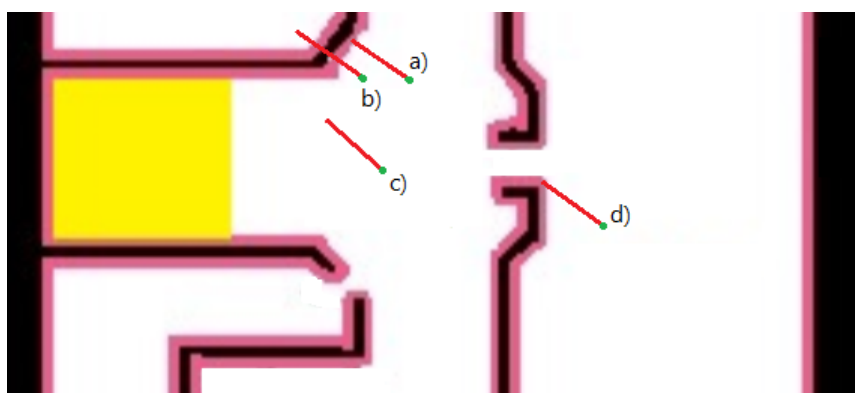
Figure 7. Consider the use of a single point light detection and ranging (lidar) sensor (or any other ranging sensor): The red vector represents such a range measurement (length and angle). Particles ( a ) and ( d ) represent good sensing points because they are within the right range (pink region). The grades of Particles ( b ) and ( c ) will be decreased. The case of Point ( b ) might be due to temporal blockage (e.g., human), whereas Point ( c ) most probably is in the wrong